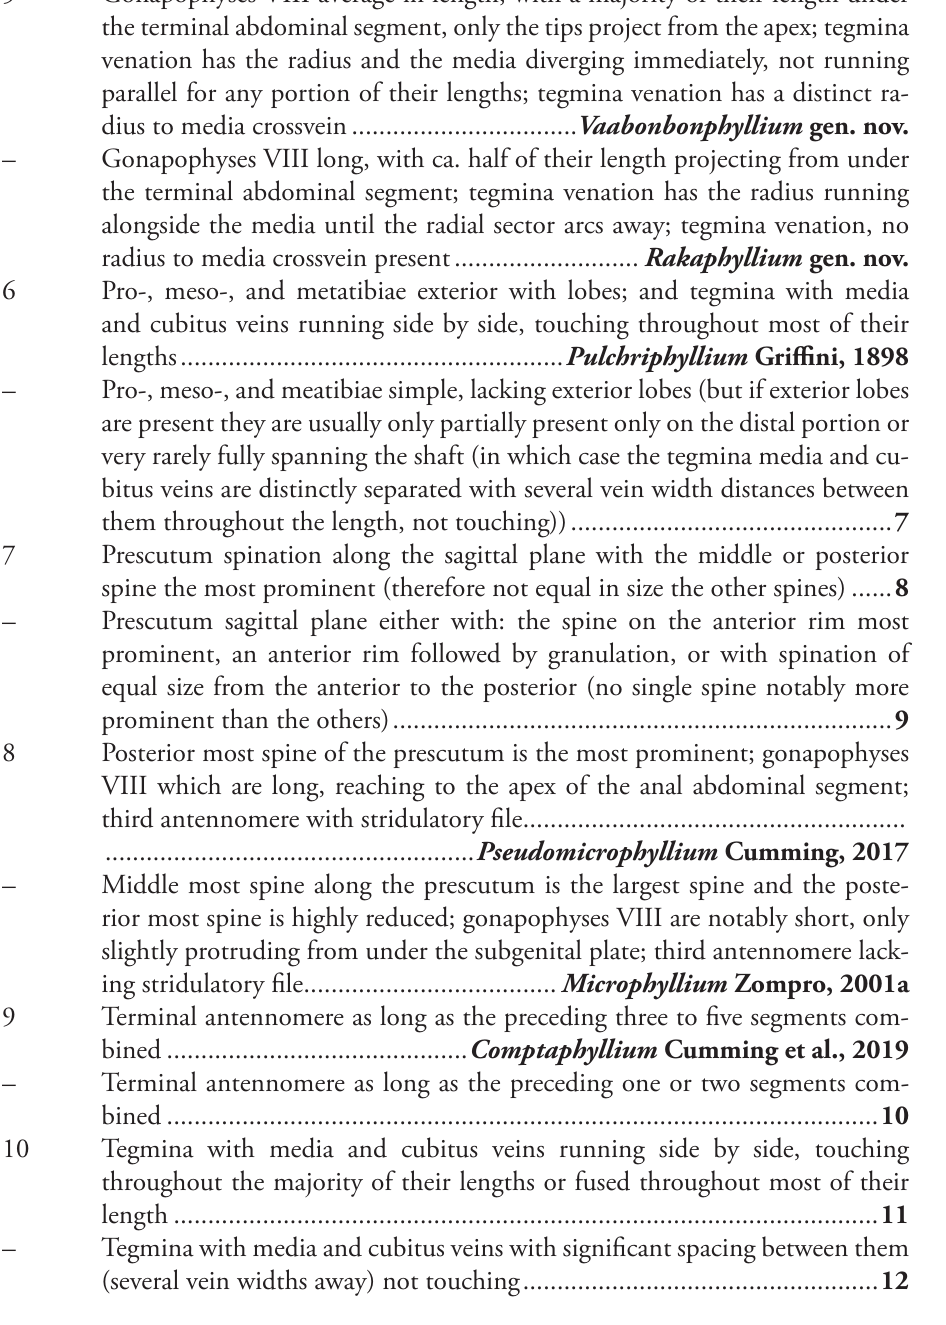
– Middle most spine along the prescutum is the largest spine and the poste- rior most spine is highly reduced; gonapophyses VIII are notably short, only slightly protruding from under the subgenital plate; third antennomere lack- 9 Terminal antennomere as long as the preceding three to five segments com- – Terminal antennomere as long as the preceding one or two segments com- 10 Tegmina with media and cubitus veins running side by side, touching throughout the majority of their lengths or fused throughout most of their – Tegmina with media and cubitus veins with significant spacing between them (several vein widths away) not touching ....................................................